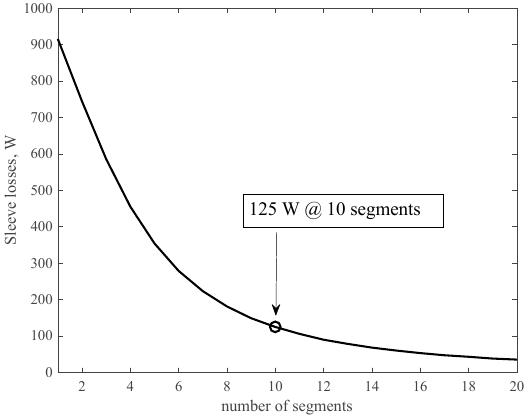
Figure 8. Sleeve losses as a function of the number of segments of the sleeve for Mot24 2 .